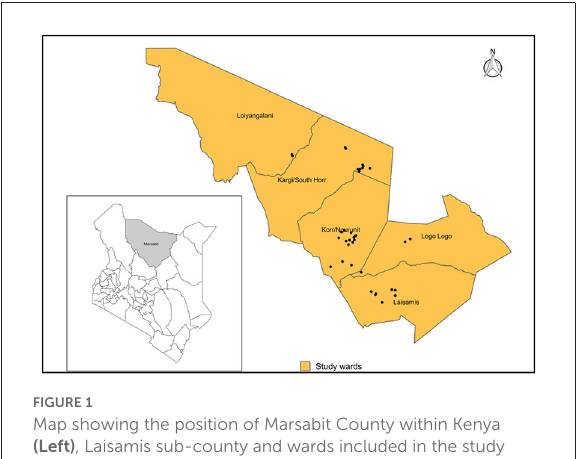
FIGURE1 Map showing the position of Marsabit County within Kenya (Left) , Laisamis sub-county and wards included in the study indicating all sampled villages (Black dots). Shapefile source: